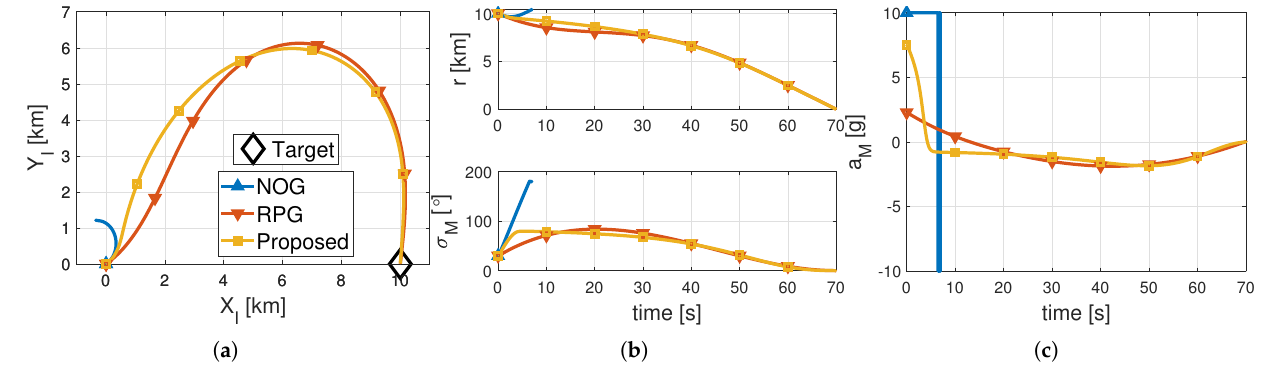
Figure 5. Simulation results under NOG, RPG, and the proposed law for the desired constraint of t d = 70s. ( a ) Flight trajectories; ( b ) state variables; ( c ) guidance